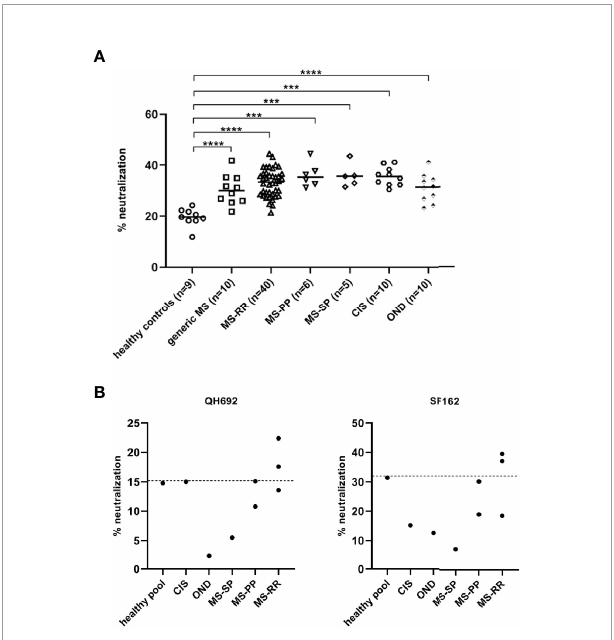
FIGURE 1 | (A) HIV-QH692 pseudovirus-blocking activity of MS-RR patients (n = 40), MS-PP (n = 6), MS-SP (n = 5), CIS (n = 10) and OND (n = 10). Healthy donors were used as negative controls (n = 9). (B) HIV-QH692 or (C) HIV-SF162 pseudovirus-blocking activities of IgG fractions from CIS (n = 1), MS-RR (n = 3), MS-PP (n = 2), MS-SP (n = 1), OND (n = 1). p-values were calculated using Student ’ s T test (****p < 0,0001; ***p <